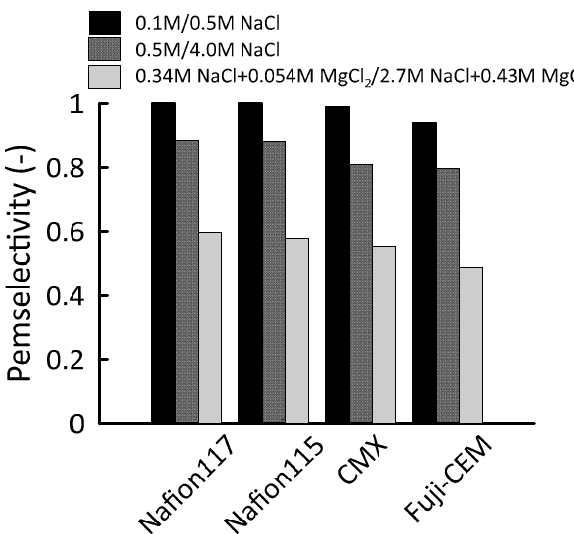
Figure 7. Permselectivity of Nafion 117, Nafion 115, Neosepta CMX, Fuji-CEM-80050 in − 0.1 / 0.5 M NaCl, 0.5/4.0 M NaCl and 0.34 M NaCl + 0.054 M MgCl 2 /2.7 M NaCl + 0.43 M MgCl 2 at 25 °C.